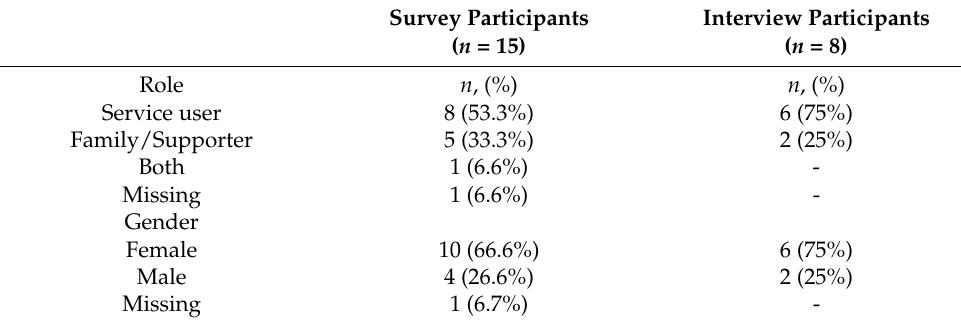
Table 1. Sociodemographic characteristics of participants.